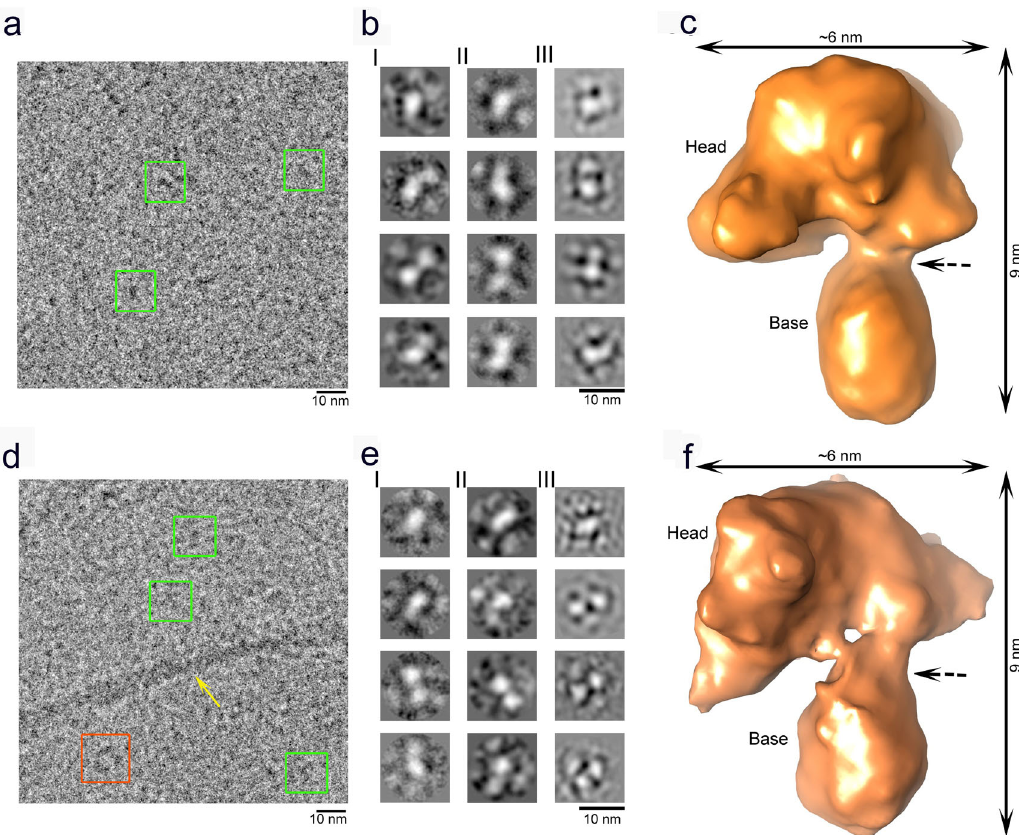
Fig. 4 Cryo-EM study of heme-stabilized α -Syn oligomers. a – c Heme treatment on monomeric α -Syn for 24 h (preincubation). a Raw micrograph showing uniformly distributed small oligomers (green squares, oligomers 1 ). b I – III Reference-free 2D class averaging analyses were done by Xmipp, RELION and EMAN2 (refer Methods). c Cryo-EM density map of α -Syn oligomers 1 . d, e Heme treatment performed after fi bril formation has initiated, i.e., after 48 h of aggregation (postincubation). d Raw micrograph showing distribution of small oligomers (oligomers 2 ) similar to oligomers 1 , as well as semi-annular- shaped oligomers and fi brils are marked by green squares, orange squares and a yellow arrow, respectively. e I – III Reference-free 2D class averaging analyses were done by Xmipp, RELION and EMAN2. f The density map of α -Syn oligomers 2 . In panels c and f , the dotted black arrow indicates the kink between the head and base of the (nondenaturing) polyacrylamide gel electrophoresis (PAGE, Supplementary Fig. 9, SI) of oligomers 1 and oligomers 2 (lanes 3 and 4, respectively) showed their migration at a MW of ~60 kDa, while the monomer migrated at ~15 kDa as has been observed before 17,45,46 thereby supporting the SEC-MALS data. These fi ndings were further validated by comparing the theoretical hydrodynamic radius (r H Theo ) of tetrameric α -Syn (prepared from PDB 2N0A) 9 using HullRad 47 (refer Methods), with the experimental hydrodynamic radius of the heme-stabilized oligomers (r H Exp ) determined using fl uorescence correlation spectroscopy (FCS, Supplementary Fig. 10, SI). FCS experiments